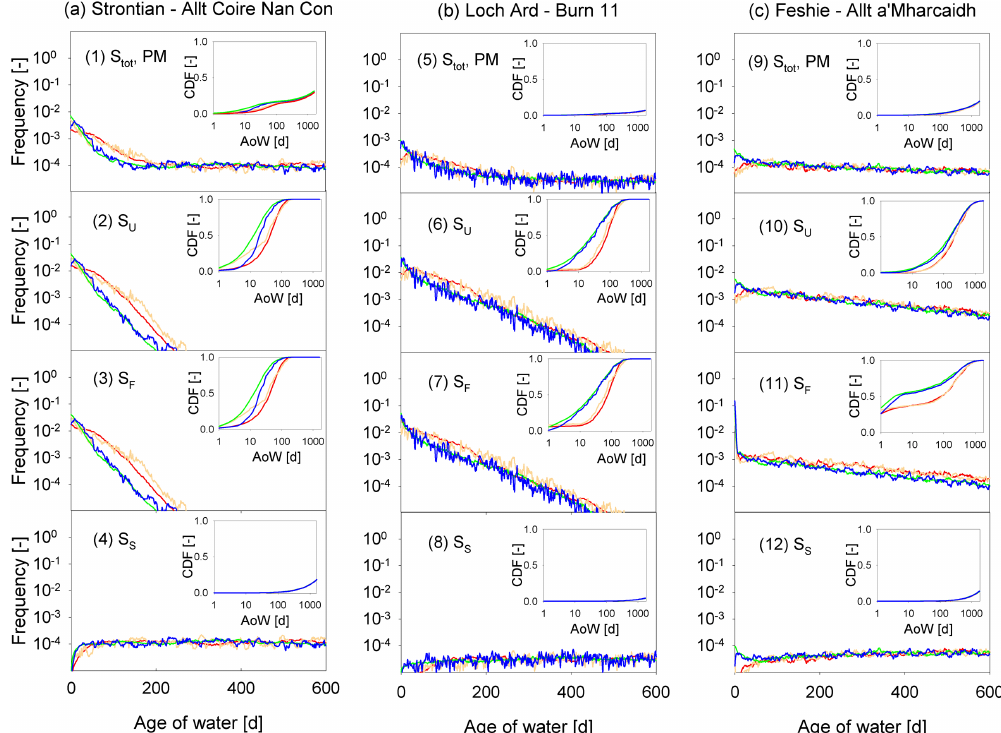
Fig. 8. Temporally averaged, unweighted resident water age distributions p R for all the total catchment water storage ( S tot ) and the individual storage elements S U , S F and S S for the PM scenarios of the three study catchments for each of the four pre-defined hydrological regimes. The averages were constructed from the median water ages for all time steps within the respective hydrological regime. The color code of the lines is corresponding to the four hydrologic regimes defined in Fig. 5: red (dry), yellow (wetting-up), green (wet) and blue